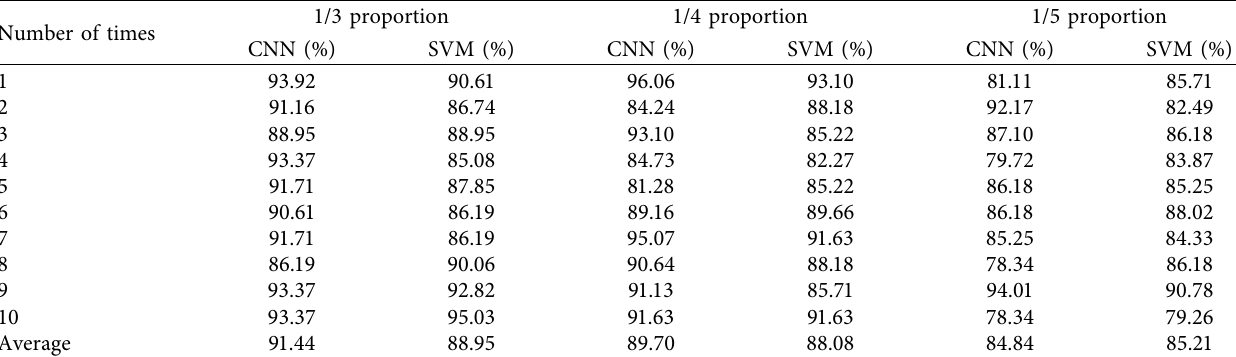
Table 10: The classification results of soil samples based on convolutional neural network and support vector machine by randomly dividing the calibration set 10